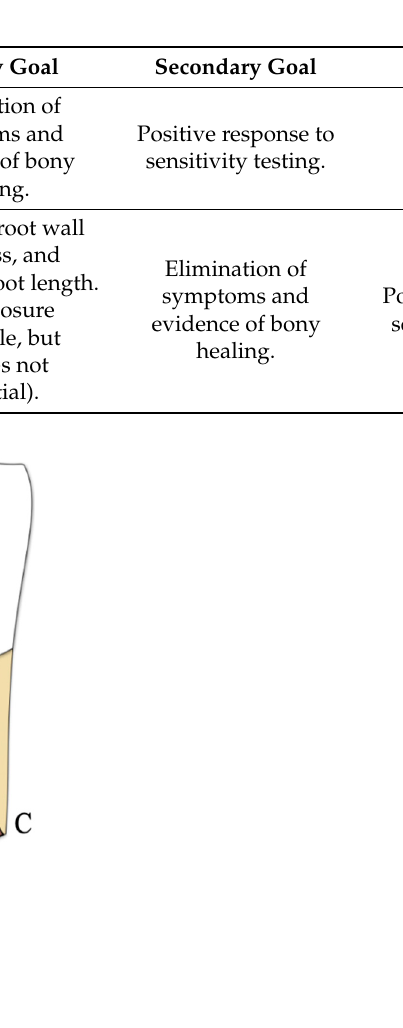
Figure 2. Population. Mature adult teeth with periapical radiolucent lesion ( A ). Immature adult teeth with ( B ) or without ( C ) periapical radiolucent lesion.